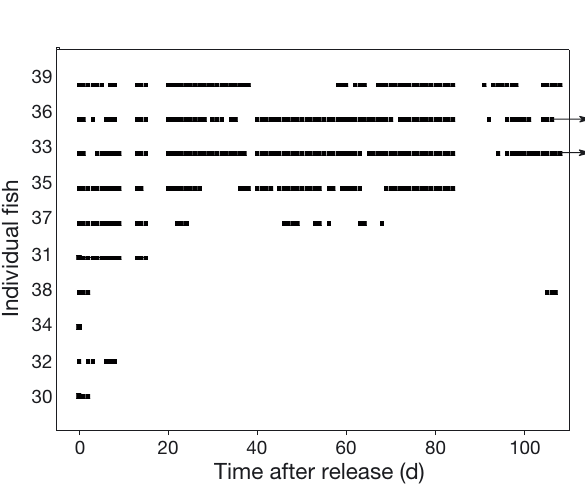
Fig. 3. Oncorhynchus mykiss . Patterns of site fidelity for 10 rainbow trout released from Farm 1 and monitored by radio- acoustic telemetry for 14 wk in 2008. Each block represents the daily presence of an individual based on detection by the farm receiver. Two rainbow trout (arrows) were detected at Farm 1 the following year (2009) 10.1 m at Farm 2 (n = 10 fish, n = 43 146 detections) for fish fitted with pressure-sensing transmitters. The Fig. 4. Oncorhynchus mykiss . Fate and movement of teleme- try-tagged rainbow trout released from 2 farms, (a) Farm 1 water column were 7 and 37% at Farms 1 and 2, and (b) Farm 2, in the North Channel of Lake Huron in 2009. The size of the circle shows the proportion of fish observed in each category; the smallest circle indicates a single fish, while the largest circle represents 26 of 30 fish at Farm 1 and 39 of 40 fish at Farm 2 in 2009. Absent: fish was not located within the week by any means; departed: a fish was de- tected moving out of the system via a receiver; man. loc.: manually located; farm: release site. At Farm 2, 3 additional receiving stations monitored fish movement (refer to Fig. 1b) — CW: gate station from Lake Wolsey to the North